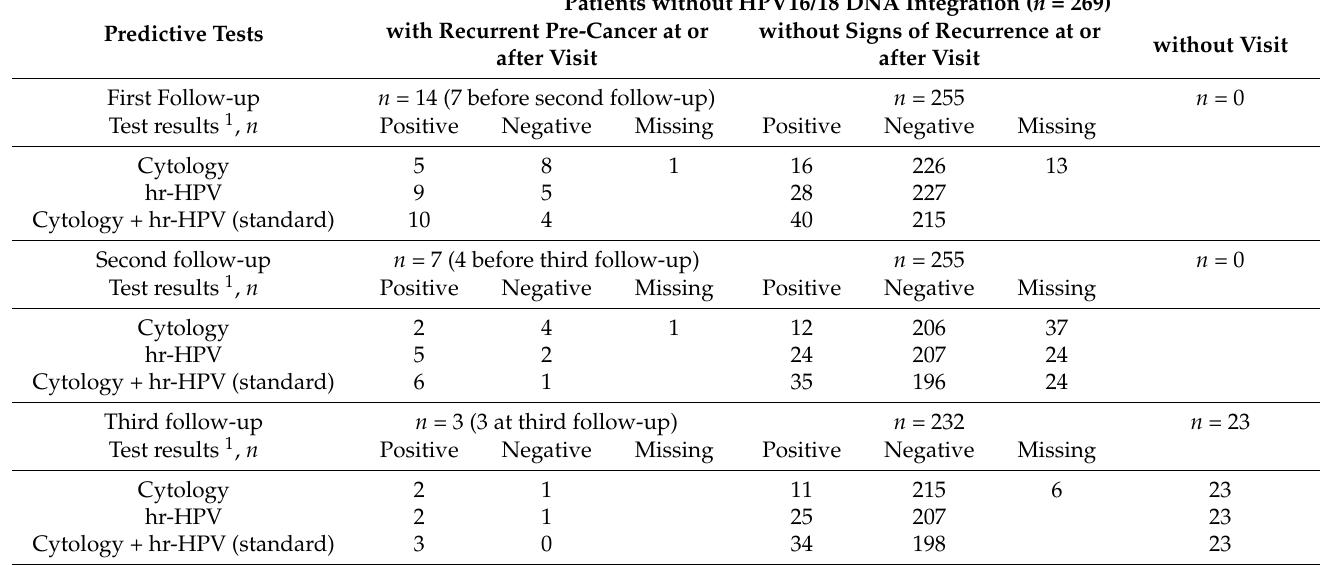
Table A2. Test results in patients without HPV16/18 DNA integration according to recurrent disease (CIN2+) at visit or afterwards (post-hoc analysis population). Patients with recurrence finished study participation after detection of CIN2+ during follow-up and were treated according to current German Guidelines.